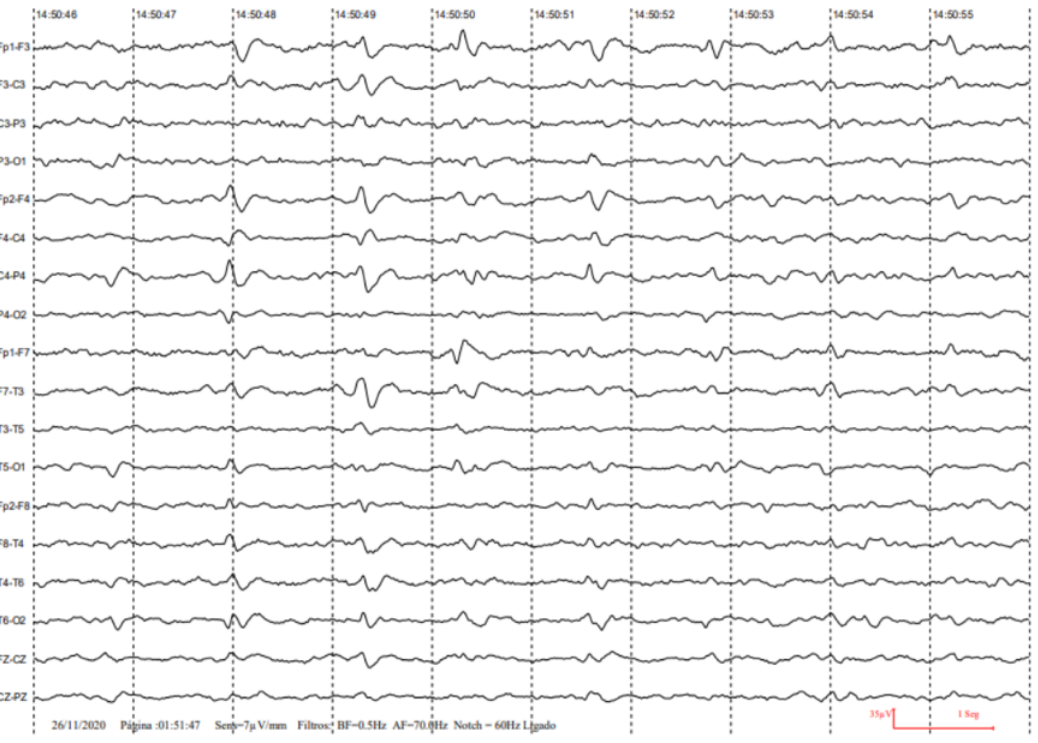
Figure 2. Periodic discharges on